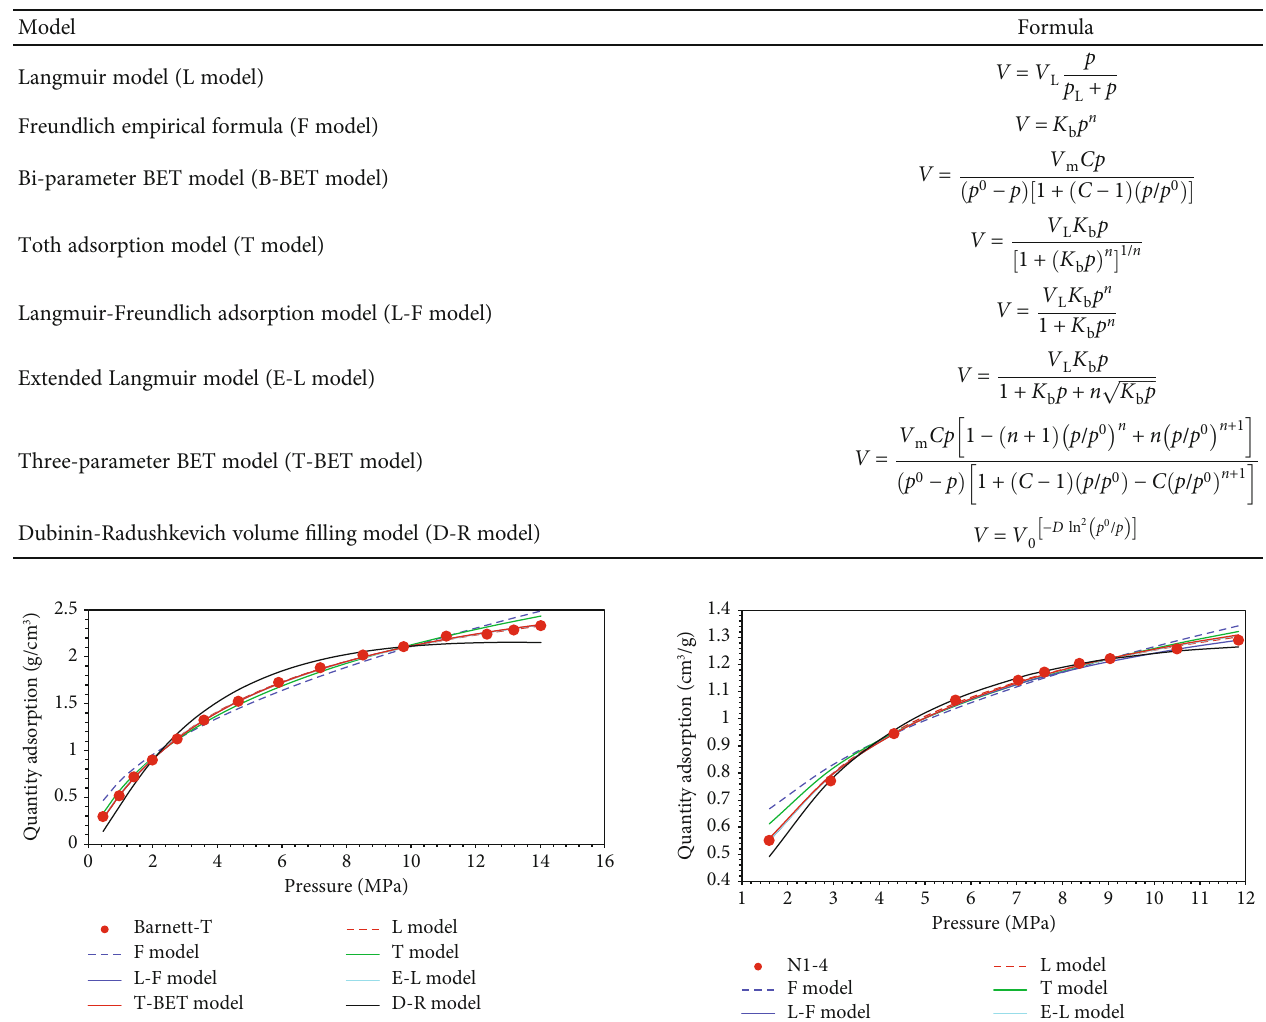
Table 1: Adsorption models and formulas [17, 20, 21].